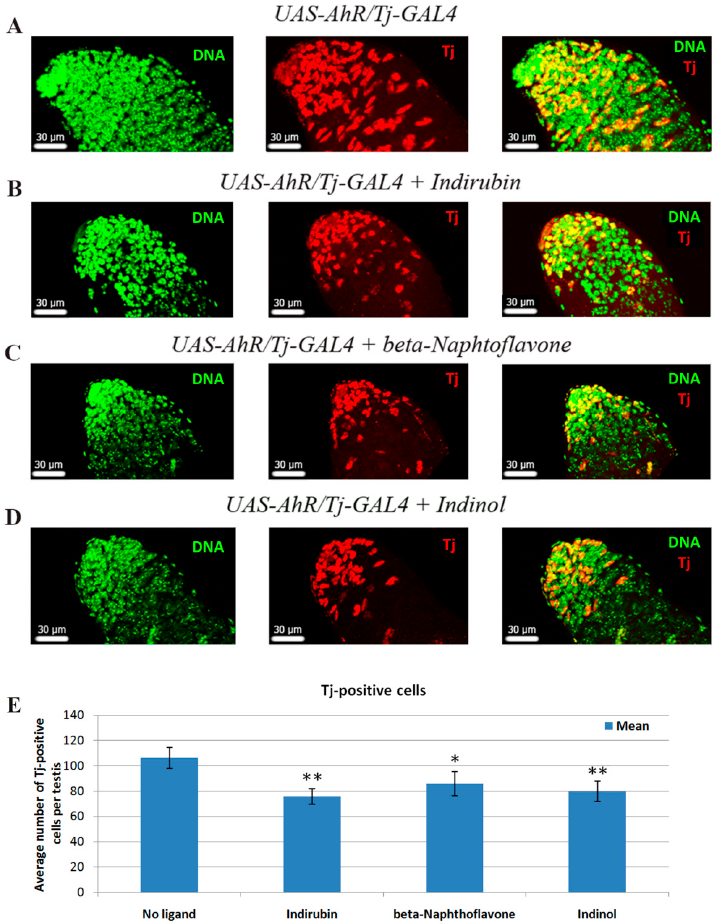
Figure 2. Xenobiotic-mediated activation of human AHR in cells of Drosophila testis causes a decrease in number of Tj-positive cells. (a-d) Confocal immunofluorescence sections of the apical tip of testes stained with SytoxGreen to highlight DNA (green) and anti-Tj to visualize Tj-positive cells (red). The third column represents merged images. (a) Testes are from flies raised on standard medium or fed for 3 days with (b) indirubin, (c) beta-Naphthoflavone, (d) indinol. All tested males were of the same UAS-AhR/Tj-Gal4 genotype. Note that apical tips of males fed with xenobiotics are smaller than apical tip of male fed with standard medium. Scale bars, 30 µm. (e) Quantification of Tj-positive cells in testes of UAS-AhR/Tj-GAL4 flies raised on standard medium (No ligand) and on medium with indirubin, beta-Naphthoflavone and indinol for 3 days counted at the 4 th day after feeding . Error bars represent 90% confidence interval of the mean. Asterisks indicate statistically significant difference using Student’s t -test (* p ≤ 0.01; ** p ≤ 0.001). In Drosophila testis, the absence of Tj-positive cells blocks normal spermatogenesis [36]. Thus, the decrease in the number of Tj-positive cells in response to human AHR activation by exogenous